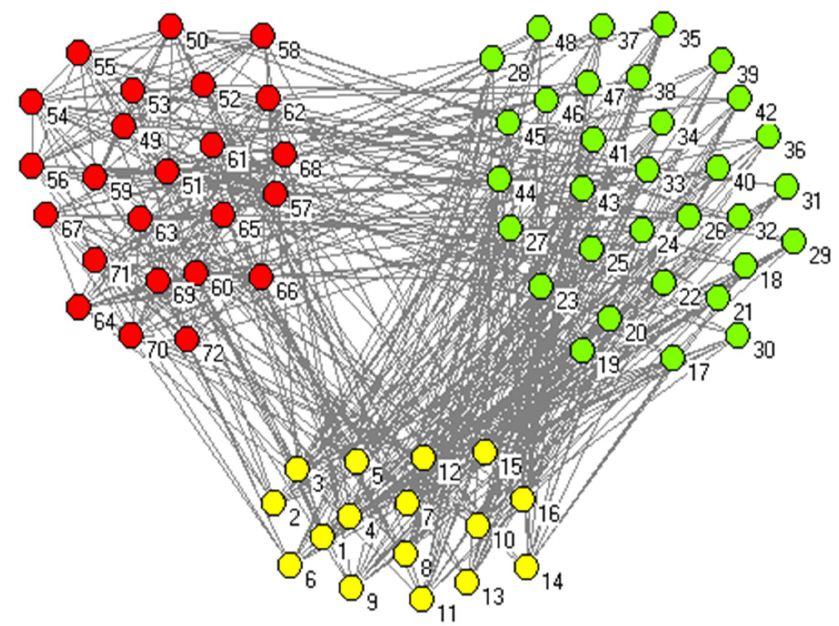
Figure 1. Generated synthetic network of this study.